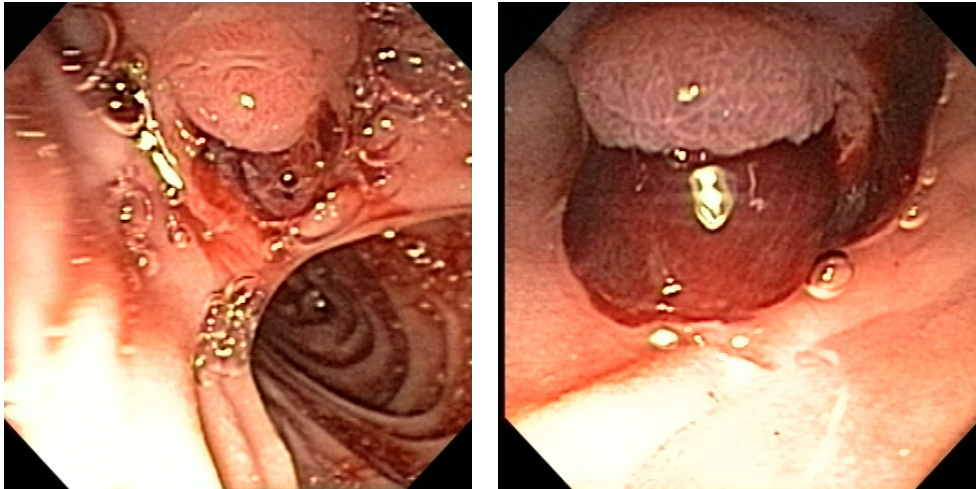
Figure 1. Ampulla of Vater showing